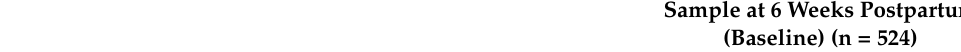
Table 1. Participant characteristics (N =